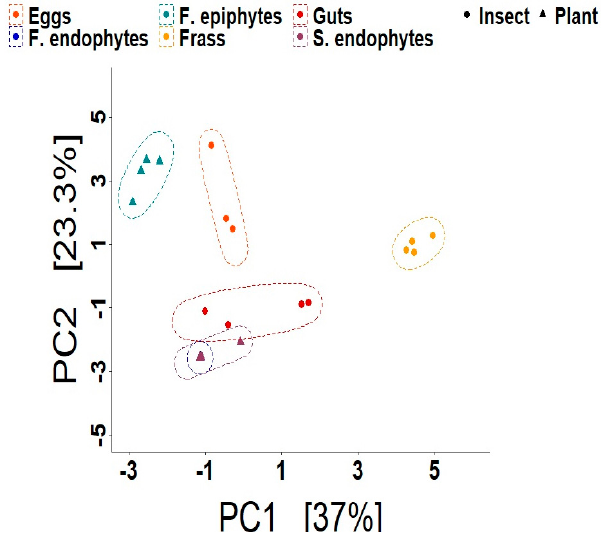
Figure 3. Beta diversity analysis for the samples of L. daturaphila (eggs, gut, and frass) and D. inoxia (foliar epiphytes). Principal component analysis (PCA) plot based on the Bray–Curtis distance of the ASVs. Each colour represents the bacteriome community in a single type of sample. The symbols represent the origin of the samples: plants or insects. The enclosing ellipses are estimated using the Khachiyan algorithm. Endophyte and seed samples were not included in this analysis, given the relatively small number of ASVs identified.